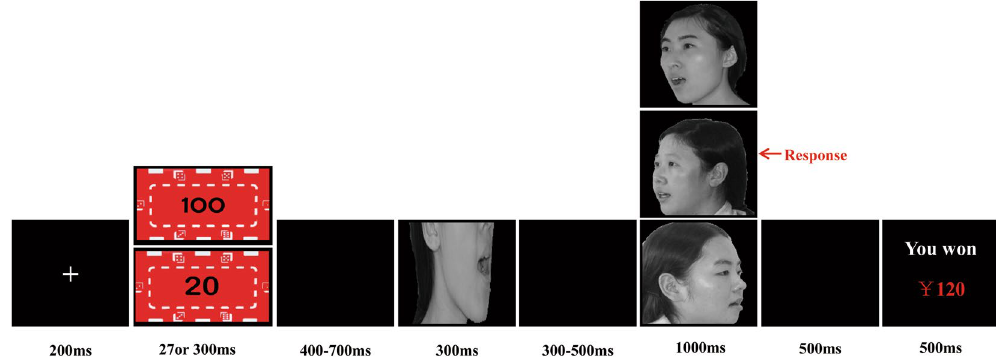
Figure 4. Panel A depicts the mean amplitudes of P3 (350–450 ms) components for self-face, friend-face and stranger-face as a funciton of presetation types and valuesof reward (Note: * p < 0.05, ** p < 0.01, *** p < 0.001). Panel B respectively displays the scatterplots with regression line illustrating the correlation between P3 mean amplitudes ( µ V) and behavioral RTs (ms) for the reward-related promotions of self-face processing under the supraliminal and subliminal representations. A negative, linear relationship was evident (Supraliminal representations: Y = − 0.018 X + 0.925, r = − 0.46, p < 0.005; Subliminal representions: Y = − 0.011 X + 0.656, r = − 0.38, p < 0.005). Specifically, Y refers to the diffence of P3 mean amplitudes between high and low rewards, and X refers to the difference of RTs between high and low